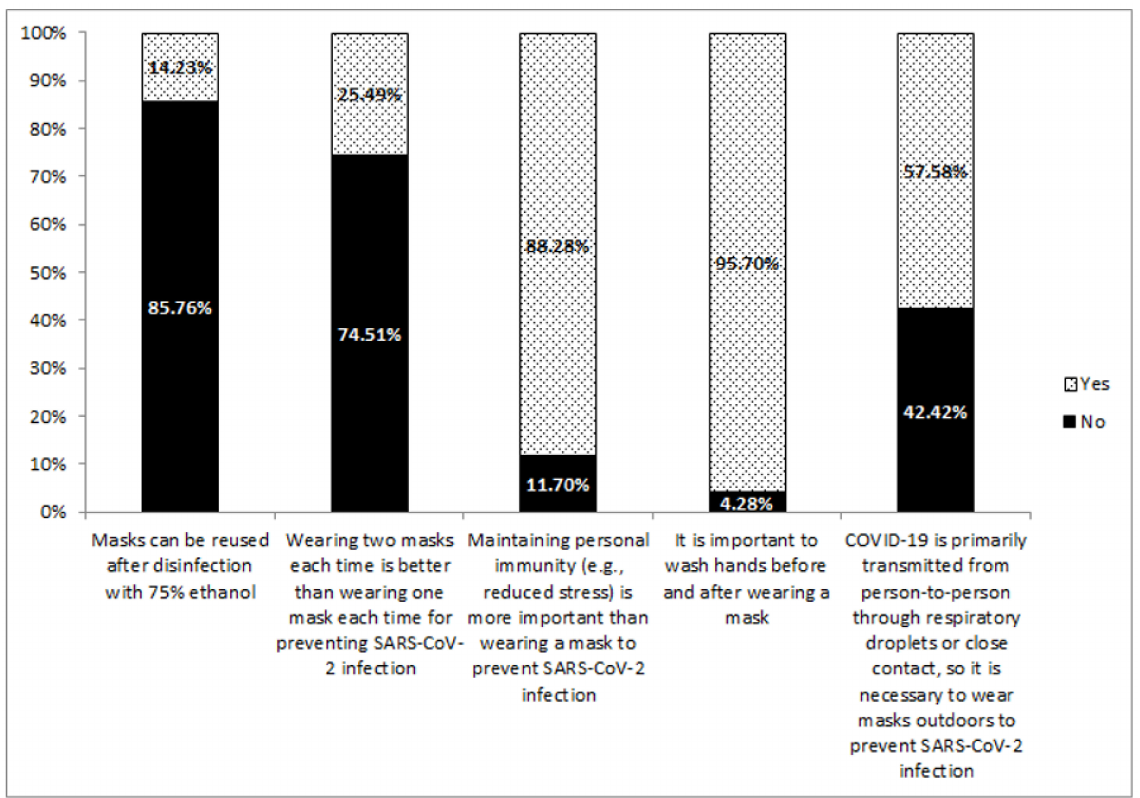
Figure 1. Knowledge on mask usage among study participants during the COVID-19 pandemic in Taiwan ( N =